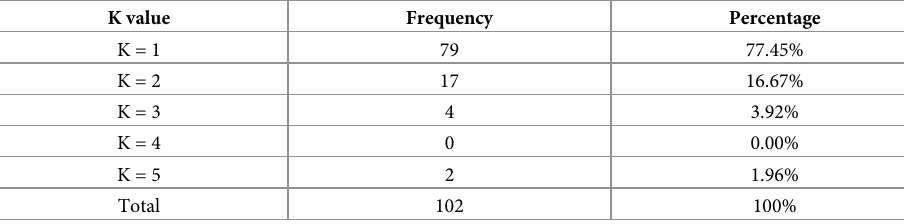
Table 1. The best-K value distribution for 102 ligand-trained KNN